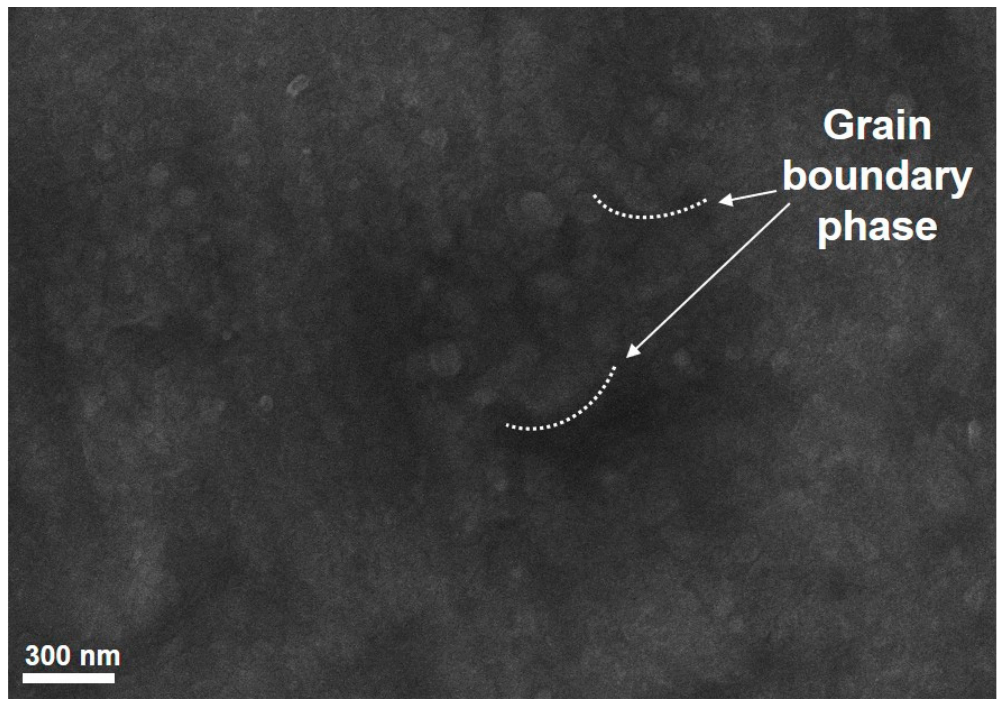
Figure 4. SEM images of the catalyst precursor.